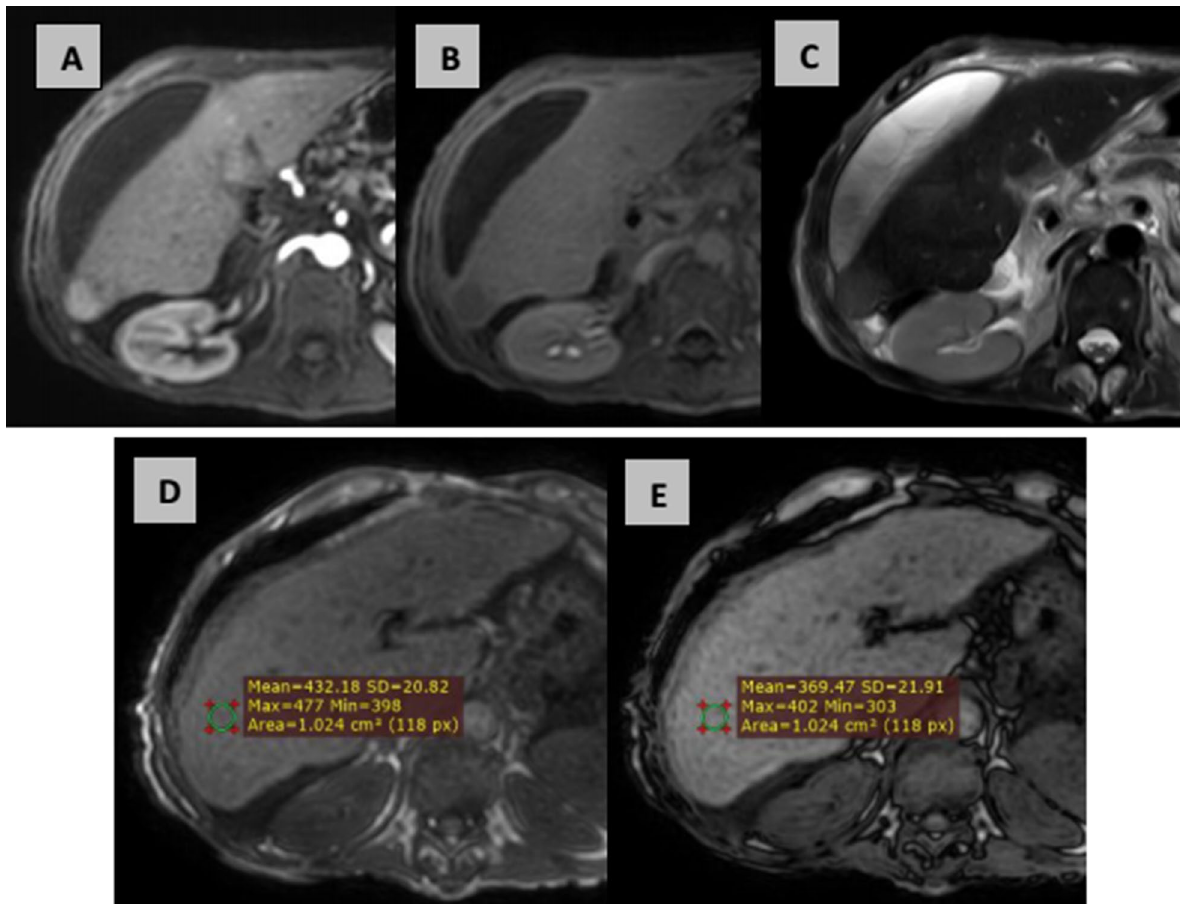
Fig. 4 A 59-year-old male patient with moderate cirrhosis and single HCC lesion at segment VI. A Early arterial phase, B delayed phase, C T2 WI, D in-phase gradient echo, E opposed phase gradient echo. The lesion elicits mild high T2 signals and shows early non-rim APHE and non-peripheral contrast washout. Moderate amount of ascites is present. Hepatic fat fraction: 7.3% (mild steatosis). Major HCC features: non-rim APHE (early), non-peripheral “washout” (early) and size 2.3 2.5 cm. Ancillary HCC features favoring malignancy: mild T2 hyperintensity. Please note the = × absence of the delayed enhancing capsule in this